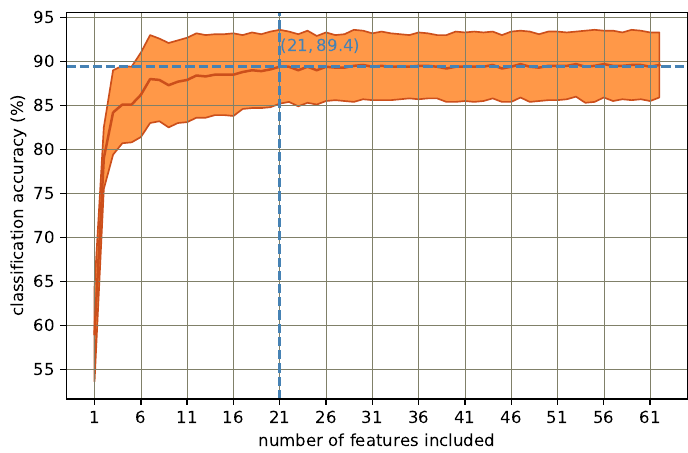
Figure 5. Classification accuracy of the RF classifier every time one feature was added to the feature set. The shaded areas show ± one standard deviation from the mean value.